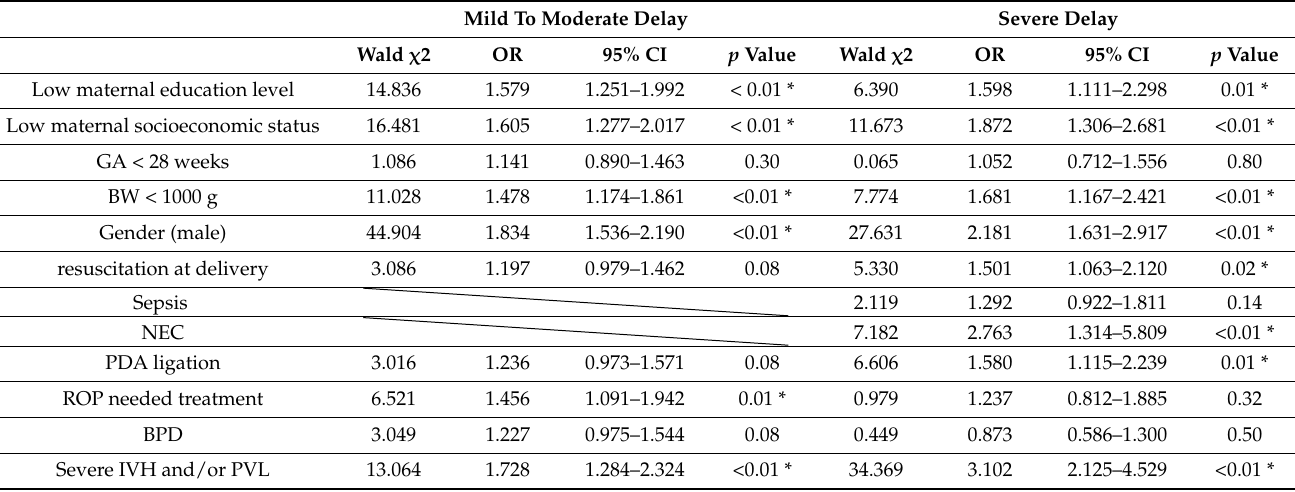
Table 2. Risk factors of mild to moderate and severe language delay.